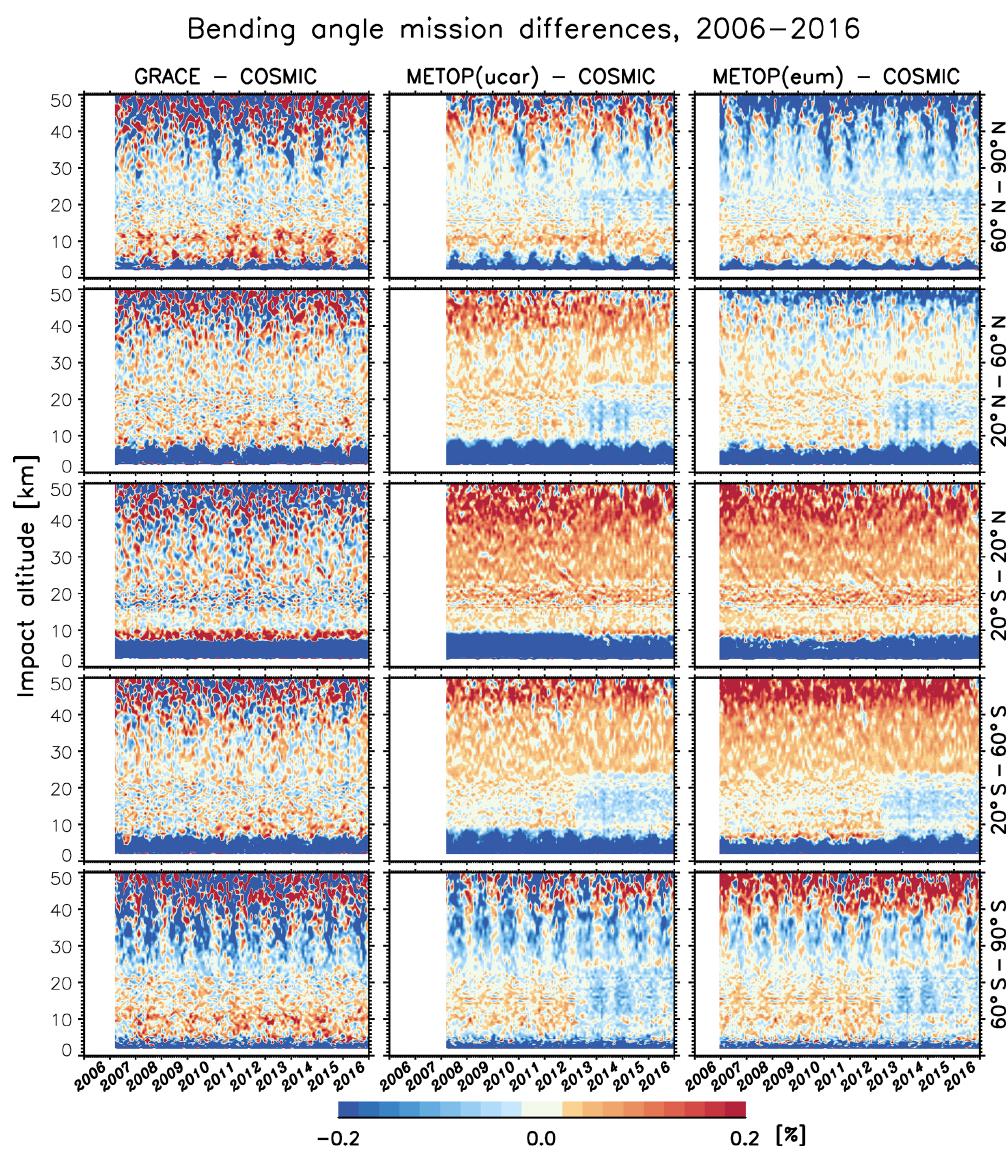
Figure 8. Differences between monthly mean bending angle climatologies retrieved from different missions; between GRACE and COS- MIC (left column), between Metop(ucar) and COSMIC (middle column), and between Metop(eum) and COSMIC (right column), where Metop(ucar) is processed by ROM SAF based on input data from UCAR, and Metop(eum) is based on input data from EUMETSAT. Differ- ences are shown in five latitude bands, south to north from lowest panel to top